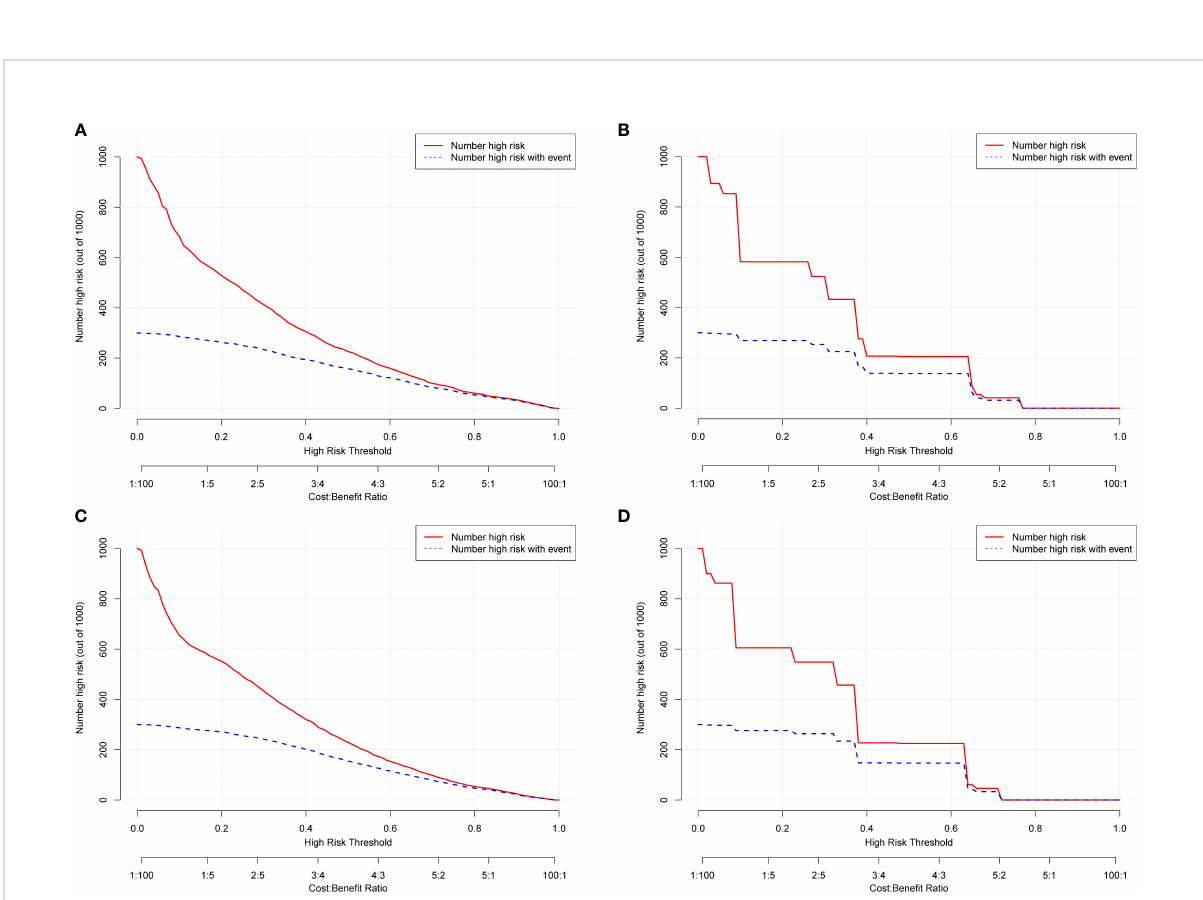
FIGURE 6 Clinical impact curves (CICs) for OS and CSS of the nomogram (A, C) and FIGO stage (B, D). The red curve (number of high-risk individuals) indicates the number of people who were classi fi ed as positive (high risk) by the model at each threshold probability; the blue curve (number of high-risk individuals with outcome) is the number of true positives at each threshold probability. The CICs provided visual con fi rmation of the high net clinical bene fi t of the nomograms and con fi rmed the clinical value of the model.